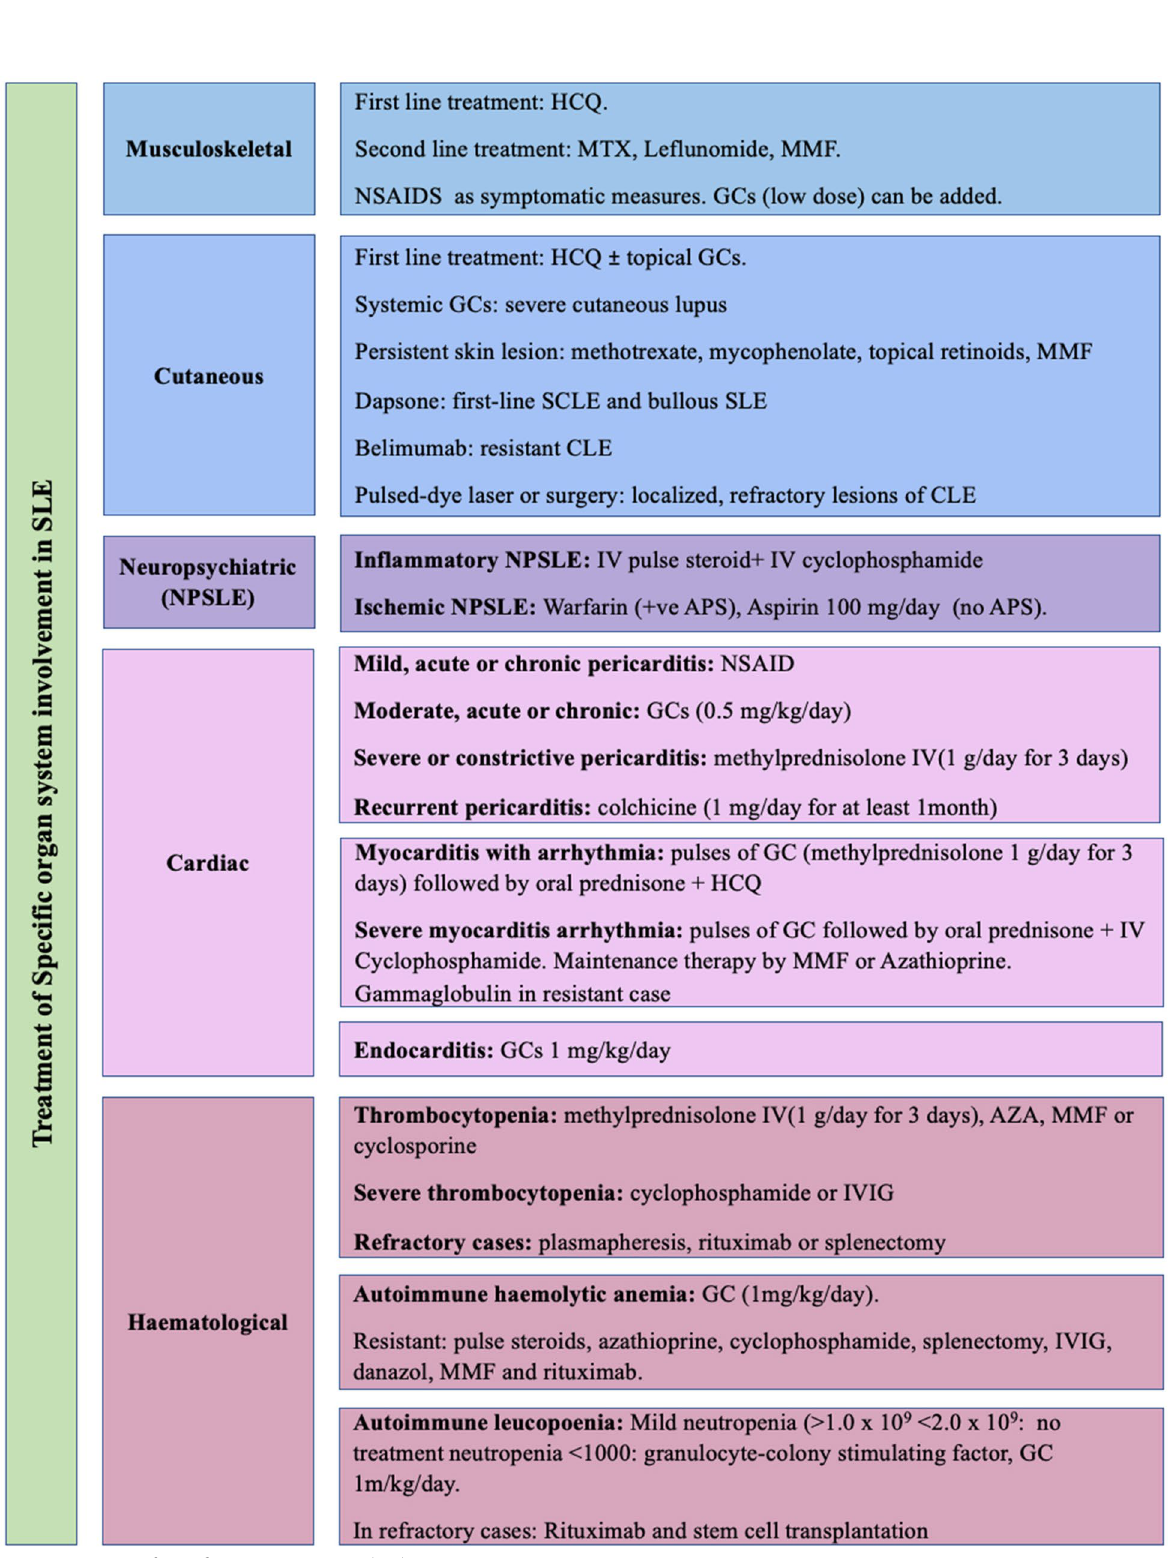
Fig. 3 Treatment of specific organ system involved in